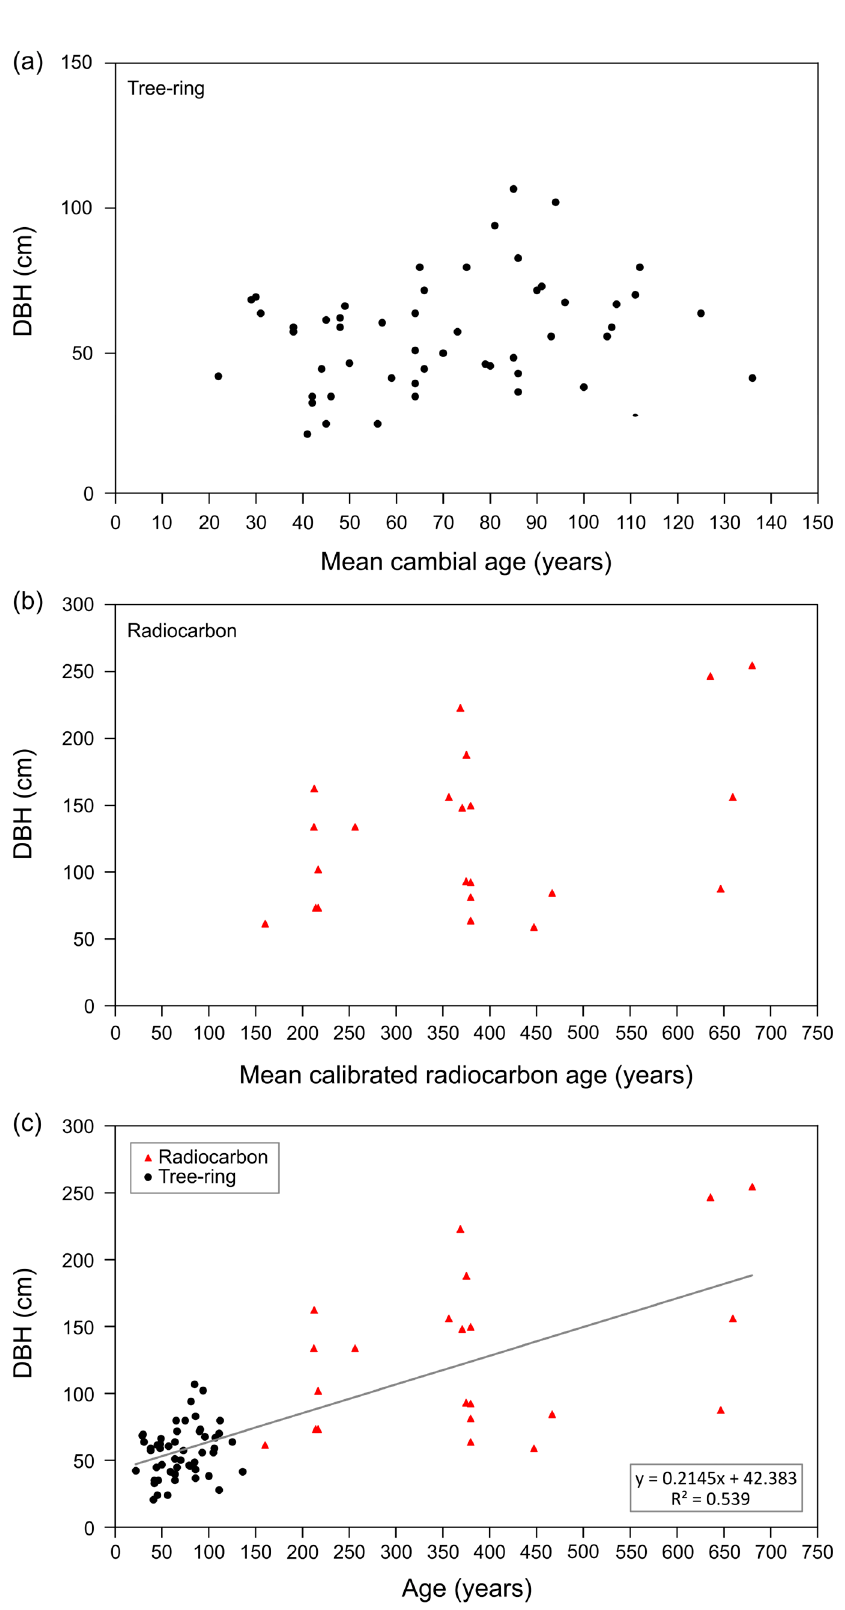
Figure 4. Age vs. diameter (DBH) relationships of fruit trees in Basilicata. ( a ) Age measured with tree-ring methods. ( b ) Age estimated with radiocarbon. ( c ) Total sample size (tree-ring and radiocarbon estimates); the linear regression line, equation, and R 2 value are shown.